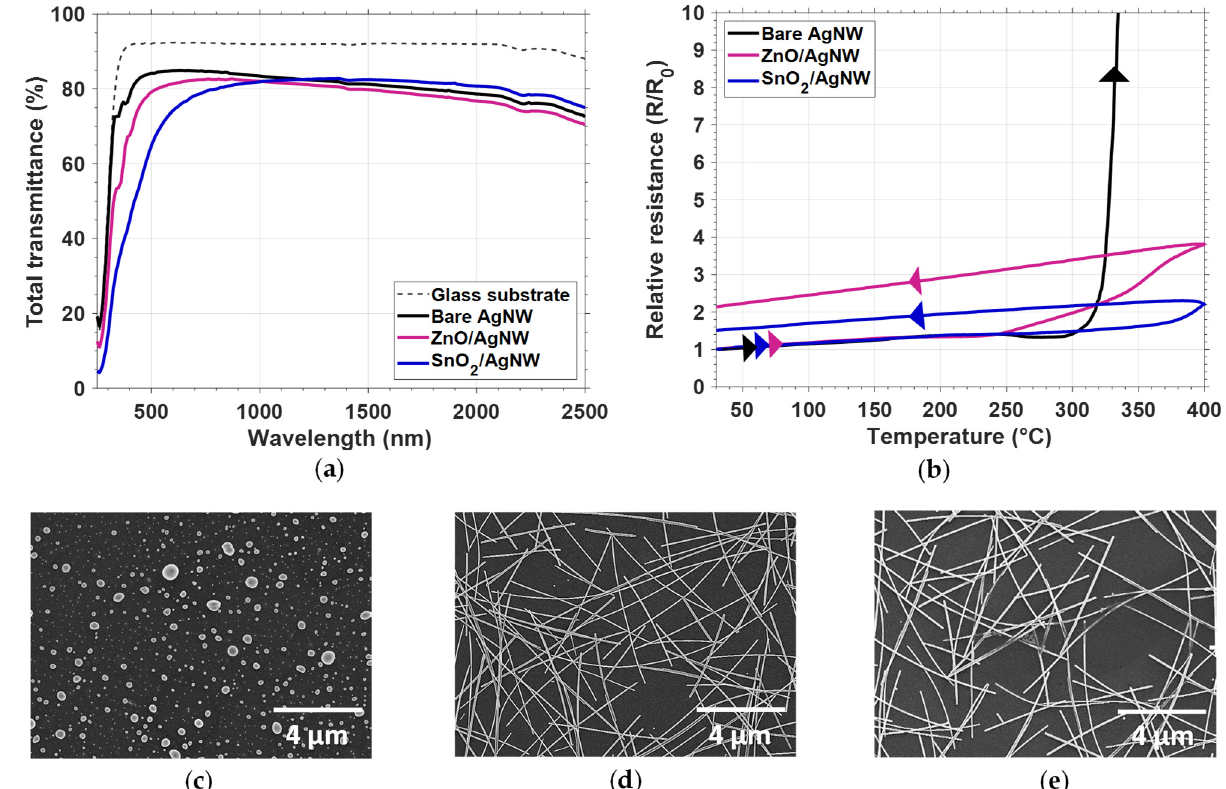
Figure 6. Effects of a thin oxide layer coating on optical transmittance and thermal stability for AgNW networks observed with a thermal ramp in air. ( a ) Dependency of total transmittance versus wavelength between 250 and 2500 nm for bare glass (grey dashed line), bare AgNW network (black continuous line), ZnO/AgNW (pink solid line) and SnO 2 /AgNW (blue solid line) nanocomposites; ( b ) Evolution of in situ electrical resistance of bare AgNWs (black solid line), ZnO/AgNW (pink solid line) and SnO 2 /AgNW (blue solid line) nanocomposites during a thermal ramp of 5 °C/min, from room temperature to 400 °C. SEM observations after a thermal ramp up to 400 °C of ( c ) bare AgNW networks; ( d ) ZnO/AgNW and ( e ) SnO 2 /AgNW nanocomposites. The ZnO and SnO 2 coating around the AgNWs was about 25 nm thick.